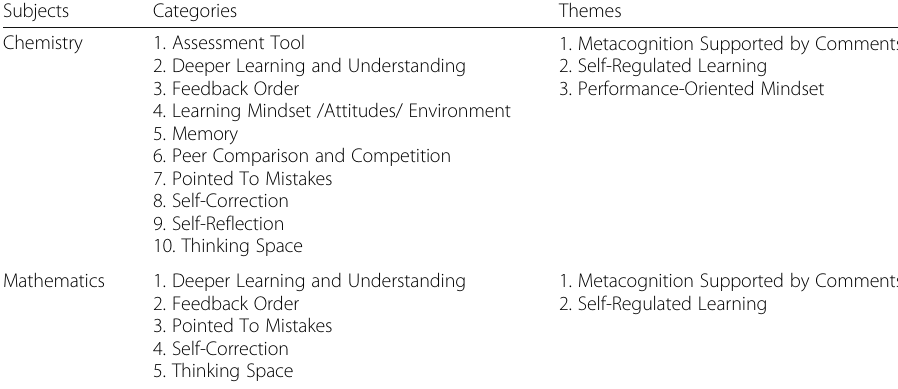
Table 5 Coding Result for Chemistry and